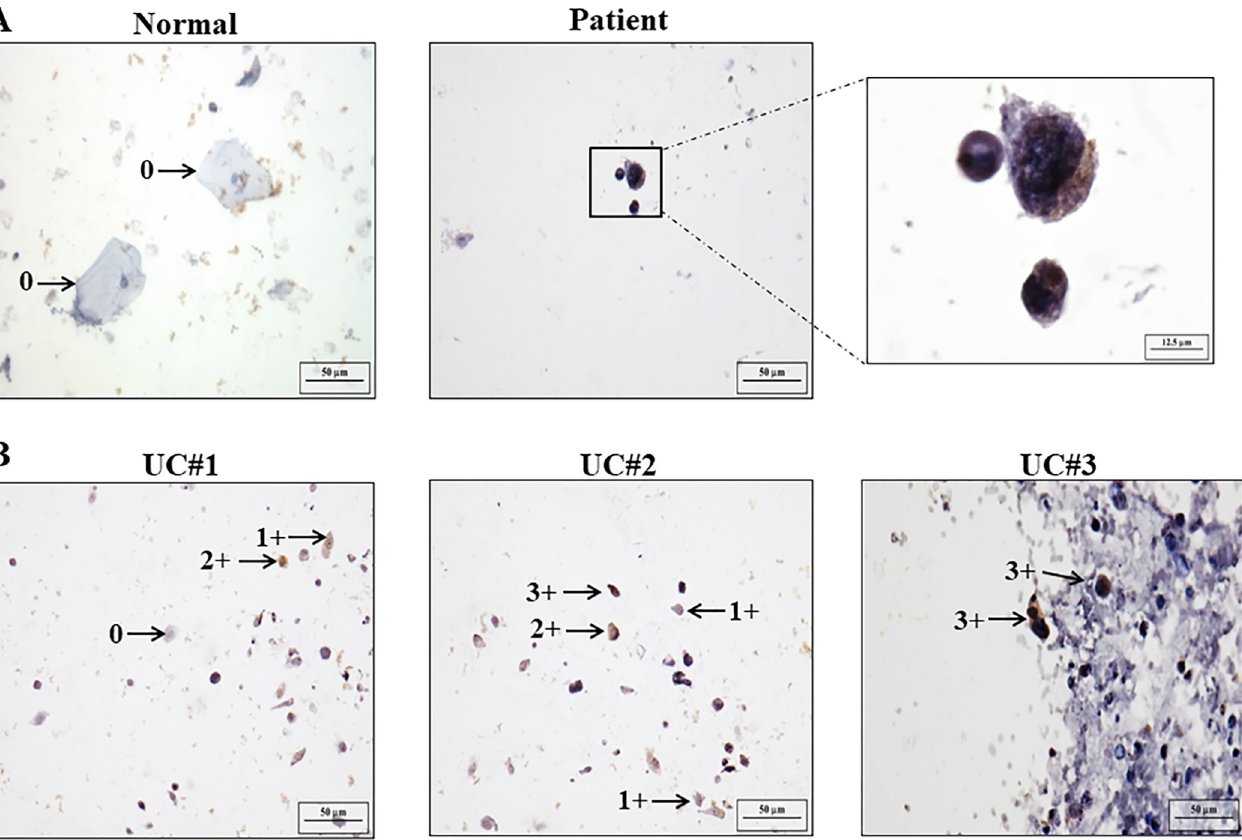
Fig 2. Detection of CDCP1 expression in UC patients by using urinary ICC method. Urine-based cells of UC patients were collected from NCKUH. CDCP1 ICC was performed by using its specific antibody as described in “Material and methods”. (A) Increased CDCP1 was observed in UC specimen. (B) The CDCP1 ICC images of three UC patients were presented. The criteria to evaluate CDCP1 expression were indicated as negative (ICC intensity = 0), weak (ICC intensity = 1), moderate (ICC intensity = 2) and strong (ICC intensity = 3). Images of tissue specimen and urine cytology were taken at 400x magnification. Scale bar indicates 50 μ